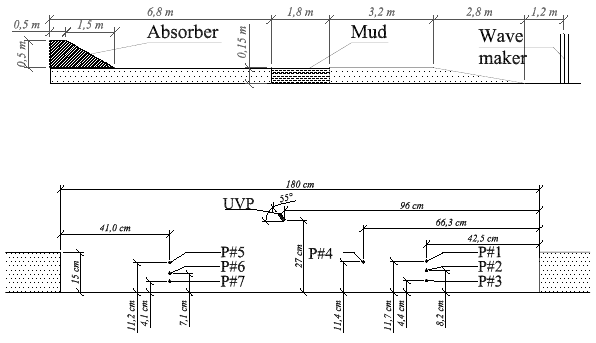
Fig. 2. Scheme of the wave flume and the experimental set-up, showing the location of the UVP transducer and the seven pore pressure sensors.